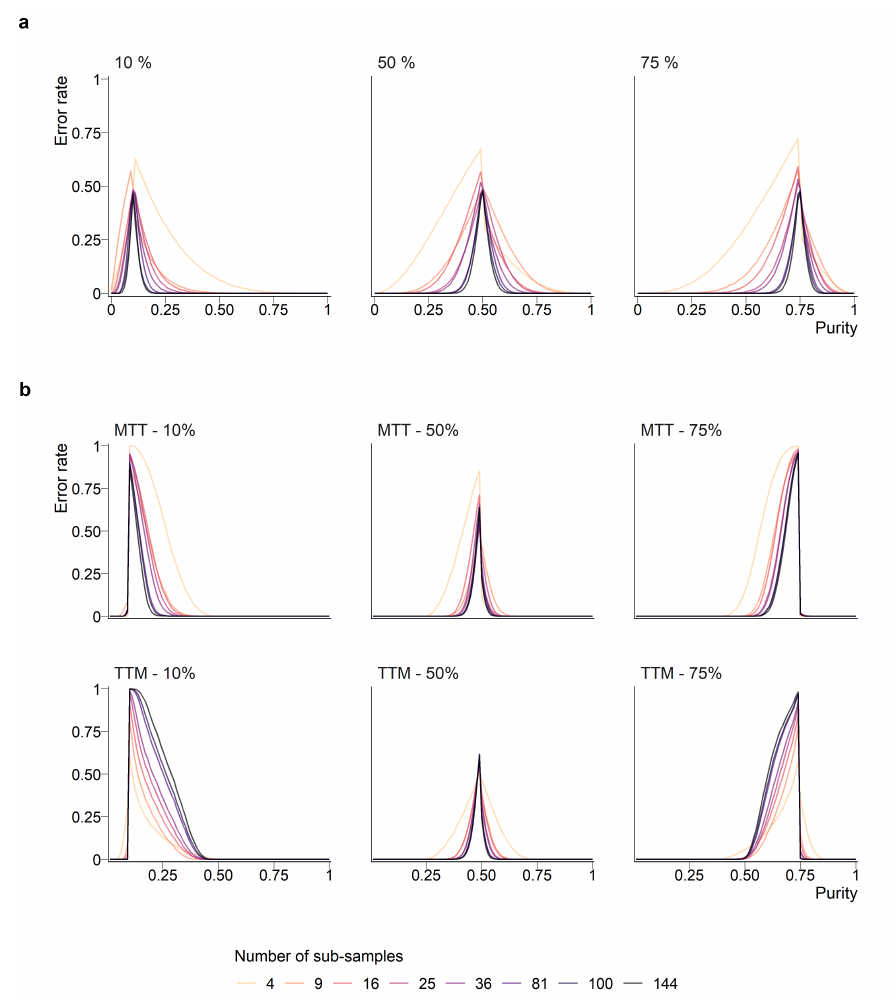
Figure 4. Error rates in reference labels as a function of landscape fragmentation for binary point-based ( a ) and partition-based ( b ) designs. The percentages in the titles of the graphs indicate the threshold that is used to determine the membership to one of the two binary classes.